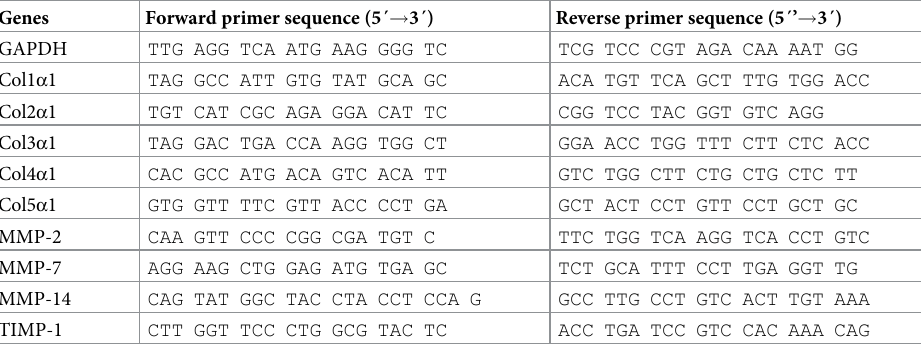
Table 1. Primers for PCR